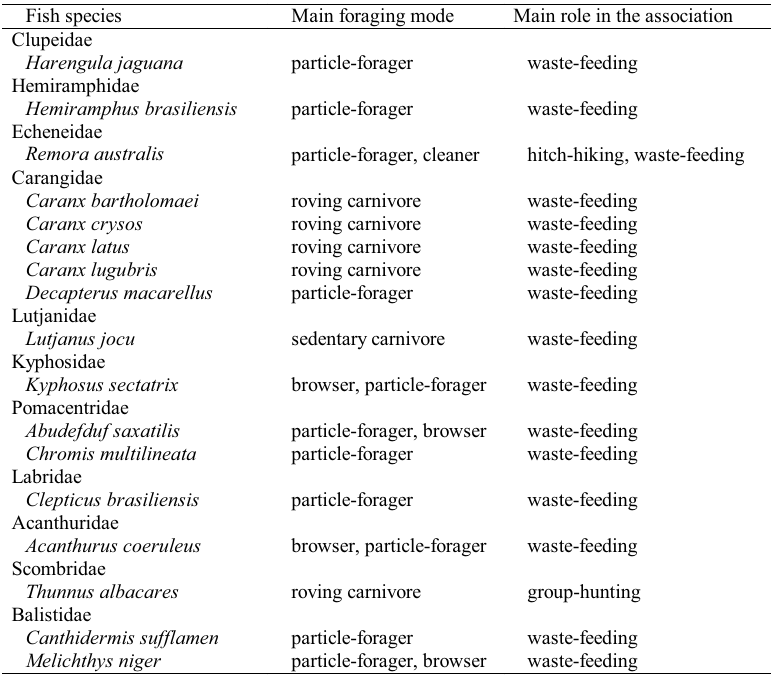
Table 1. Fish species recorded in association with spinner dolphins ( Stenella longirostris ) at Fernando de Noronha Archipelago. Arrangement of families follows Nelson (1994) except for Hemiramphidae (= Exocoetidae); species in alphabetical